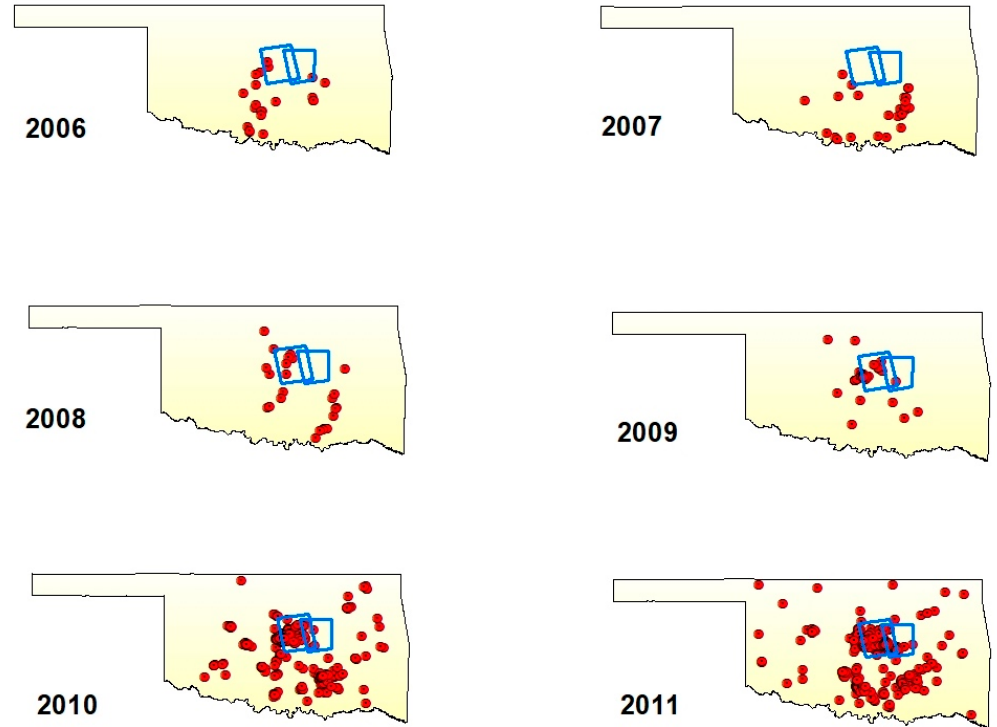
Figure 2. Earthquakes 2.9 M w or larger shown by year for the time period of InSAR analysis. Processed InSAR frames shown in blue. This time series analysis covers a period of relative seismic quietude (2006) up through significant increase in seismicity (2011).